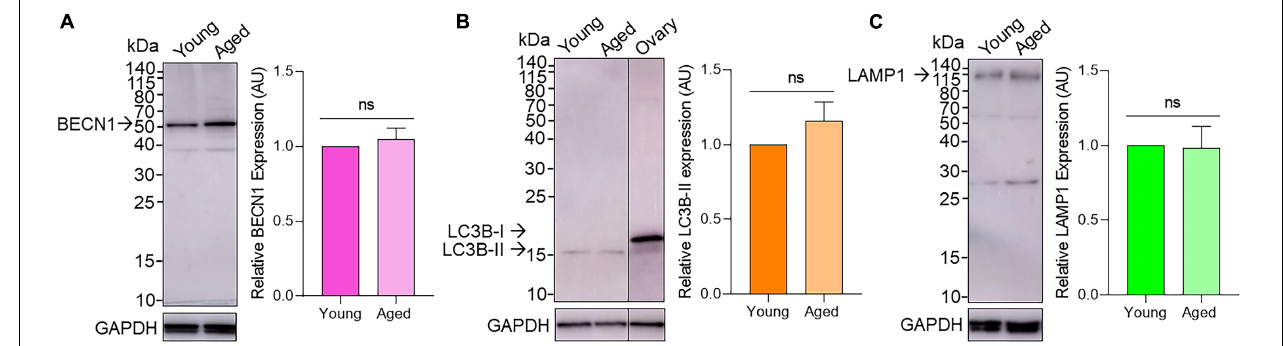
FIGURE 4 | Assessment of BECN1, LC3B, and LAMP1 protein expression in young and aged pre-ovulatory mouse oocytes. Oocyte protein lysates from young (4–6 weeks old) and aged (12–14 months old) mice were subjected to immunoblotting with (A) anti-BECN1 (52kDa), (B) anti-LC3B (19 and 17 kDa for LC3B-I and LC3B-II, respectively; including whole ovary positive control) or (C) anti-LAMP1 (120kDa) antibodies. Following detection of the target antigens, the blots were stripped and reprobed for the housekeeping protein GAPDH (35 kDa) to ensure equivalent protein loading in each lane. Densitometric analysis was performed on labeled bands corresponding to the predicted molecular weight of target proteins (please see arrows) to determine the protein abundance relative to GAPDH. Densitometric data are expressed as mean ± SEM ( n = 4, normalized to young) with statistical analysis revealing no significant (ns) differences in target protein expression between young and aged